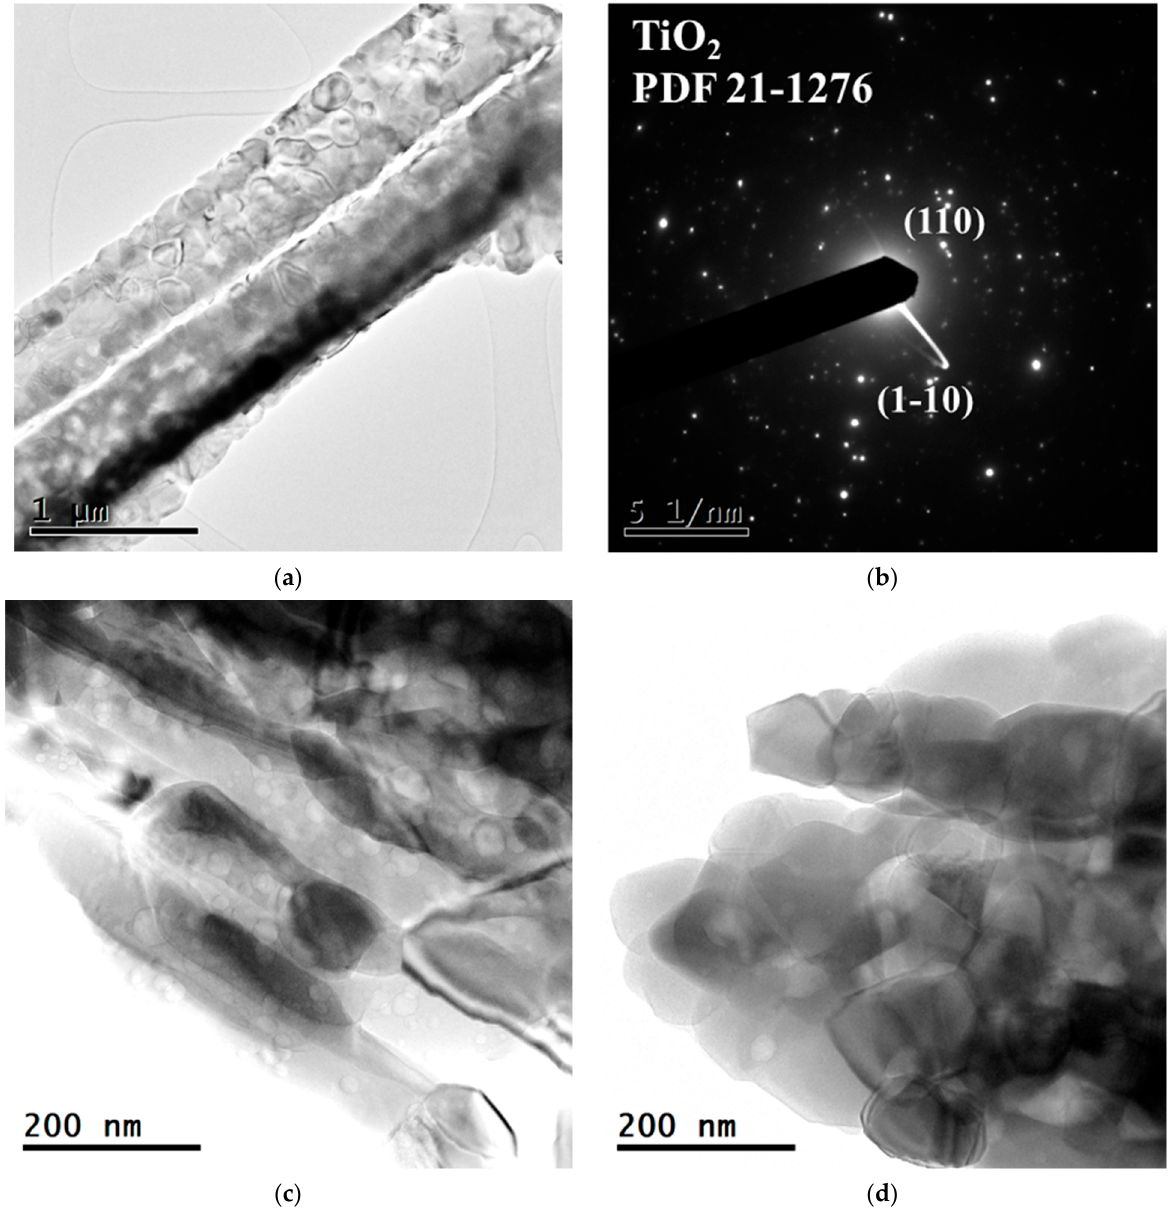
Figure 9. HRTEM analysis of sample Cu/TiO 2 _800, ( a ) Cu/TiO 2 _800 with a magnification of 1 μ m, ( b ) Cu/TiO 2 _800 SAED pattern, ( c , d ) Cu/TiO 2 _800 with a magnification of 200 nm.